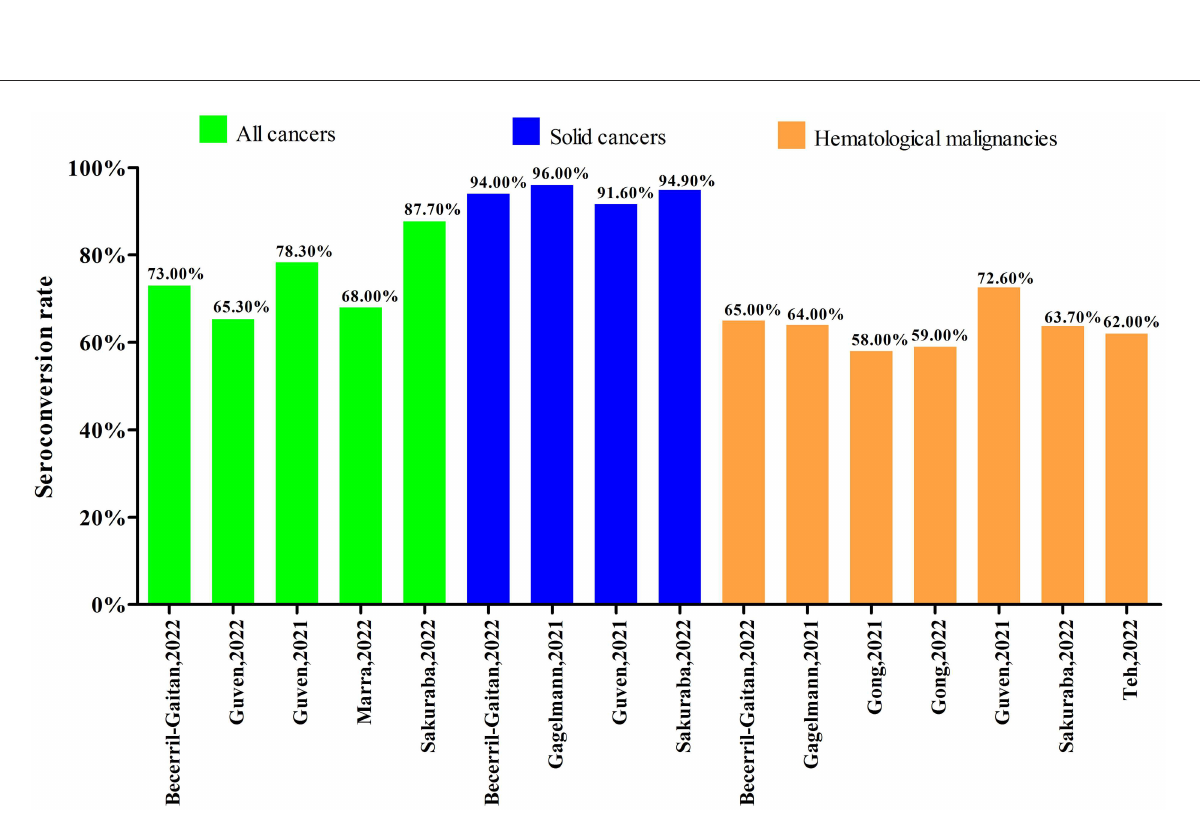
FIGURE6 Seroconversion rate after the second dose of COVID-19